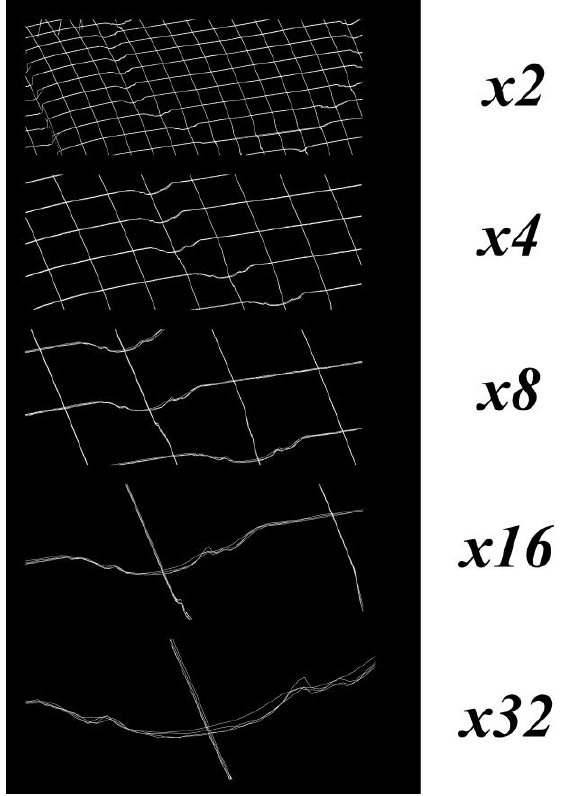
Figure 16. Registration at different magnification error of range